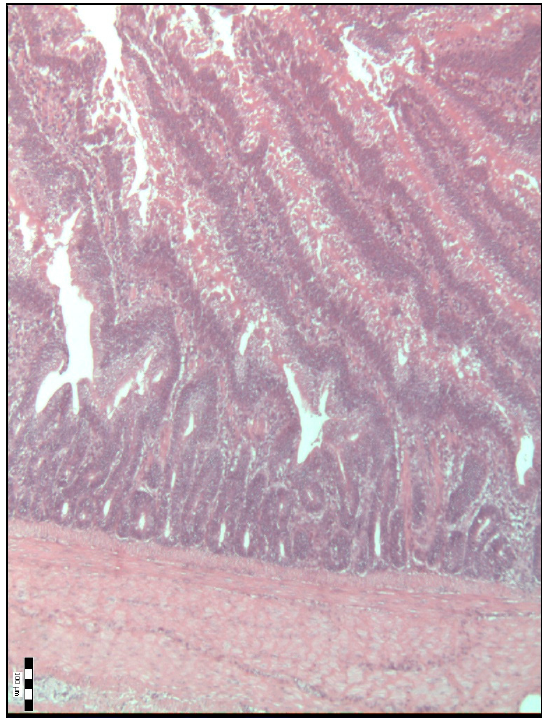
Figure 3. Histological representation of the duodenal villi of broiler chickens from the P2 experimental group of chickens (H&E; ×100).